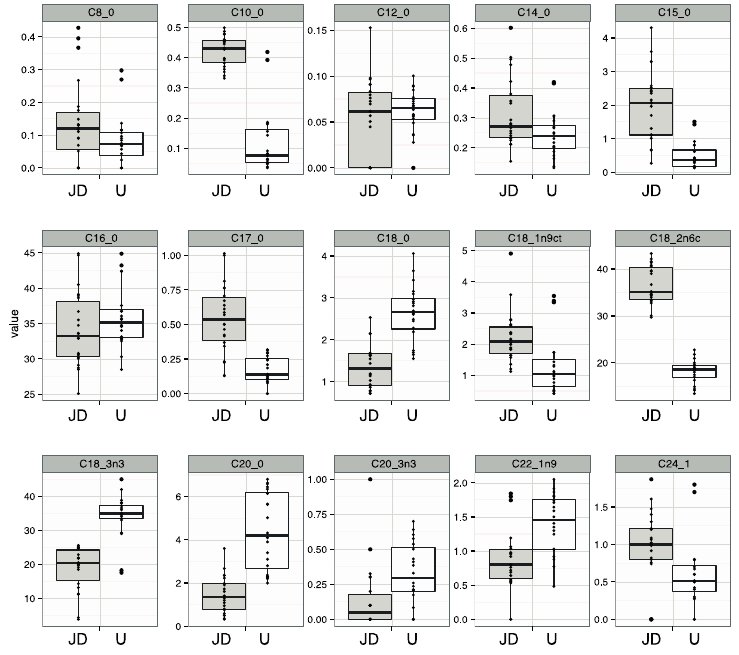
Figure 4. Box-plot for each fatty acid grouped according to sample’s